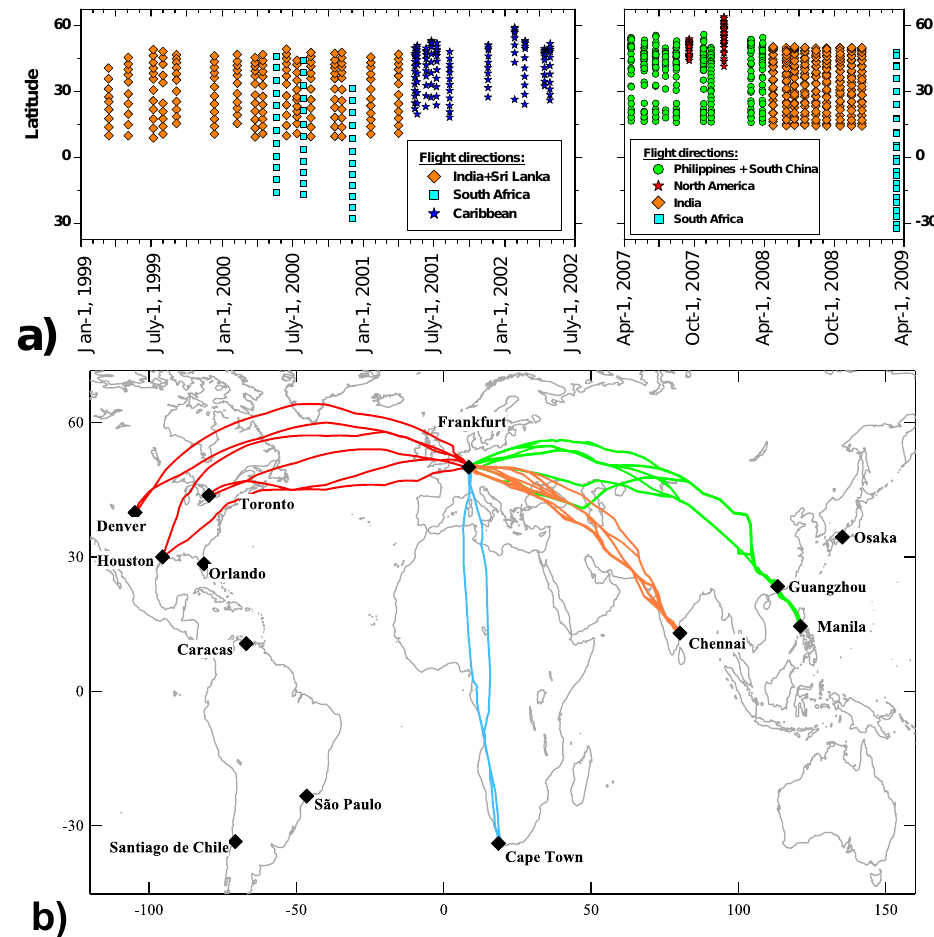
Fig. 1. (a) CARIBIC-1 and CARIBIC-2 sample distribution used for CO 2 isotope analyses; (b) CARIBIC-2 flight routes.